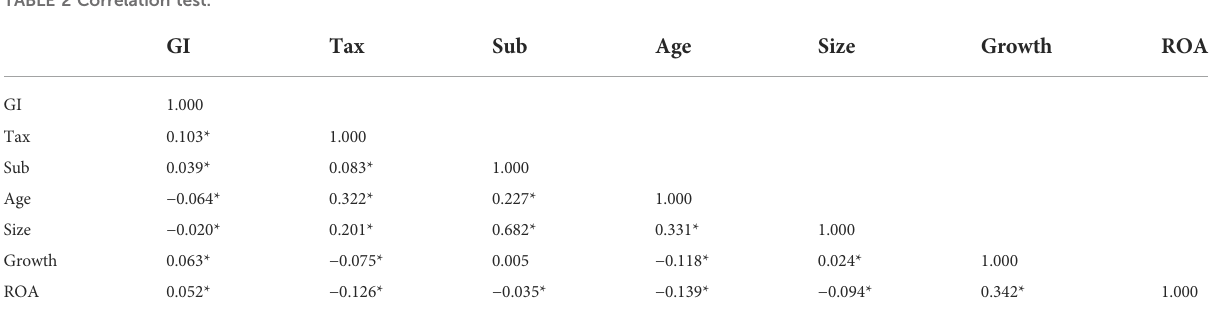
TABLE 2 Correlation test.